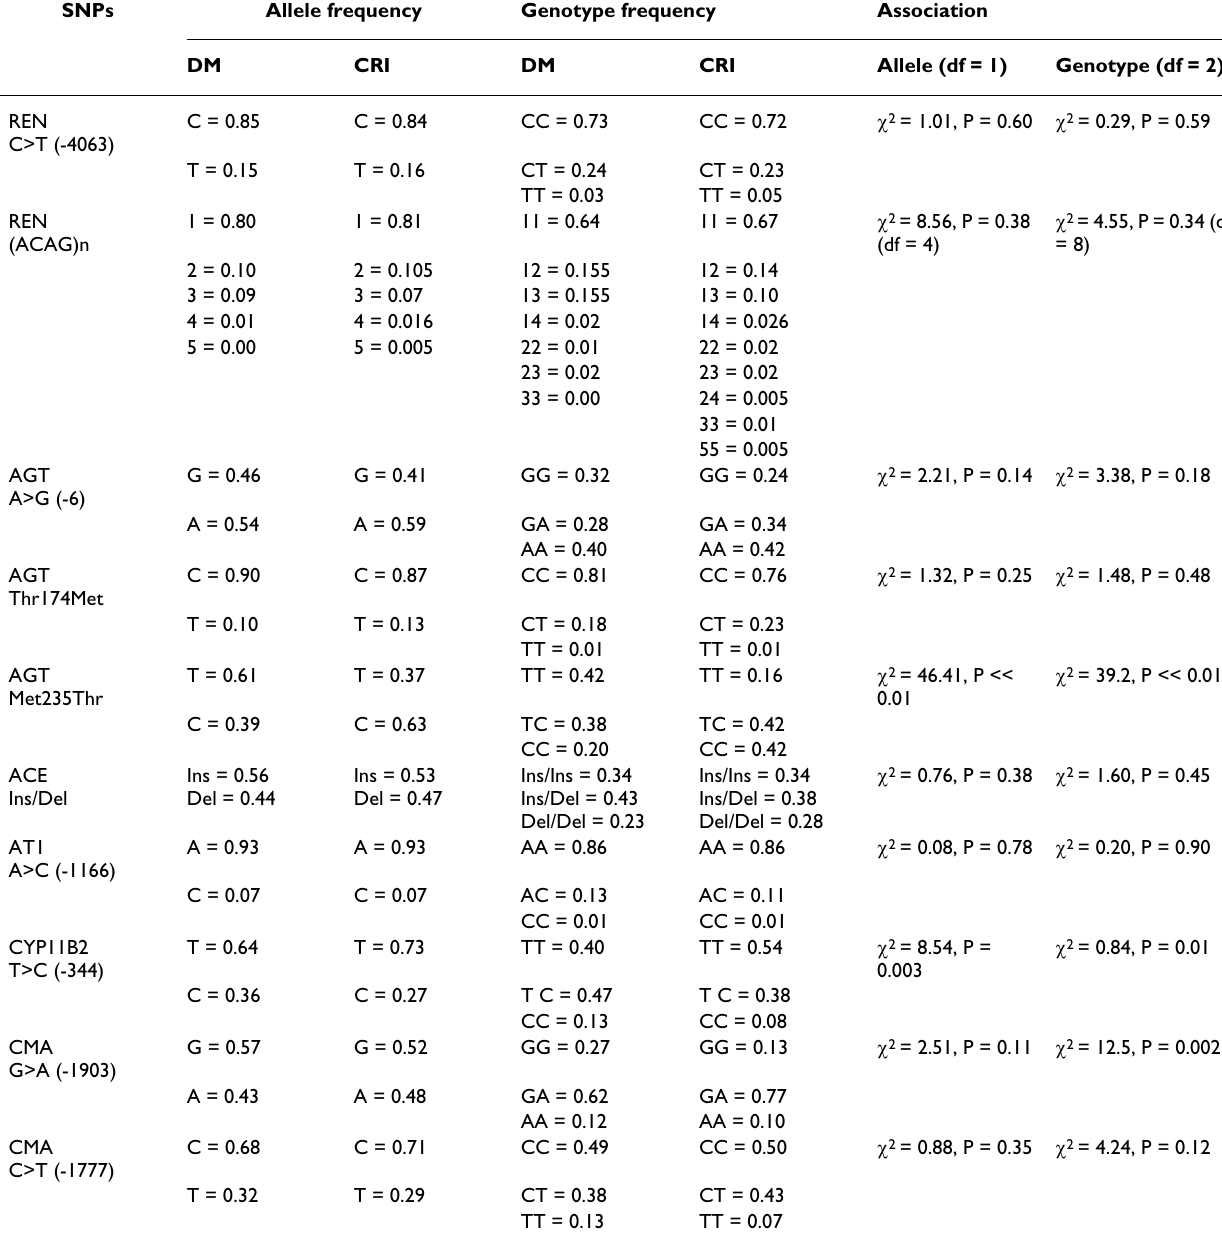
Table 3: Allele and genotype frequencies of SNPs and their association status with diabetic chronic renal insufficiency. SNPs Allele